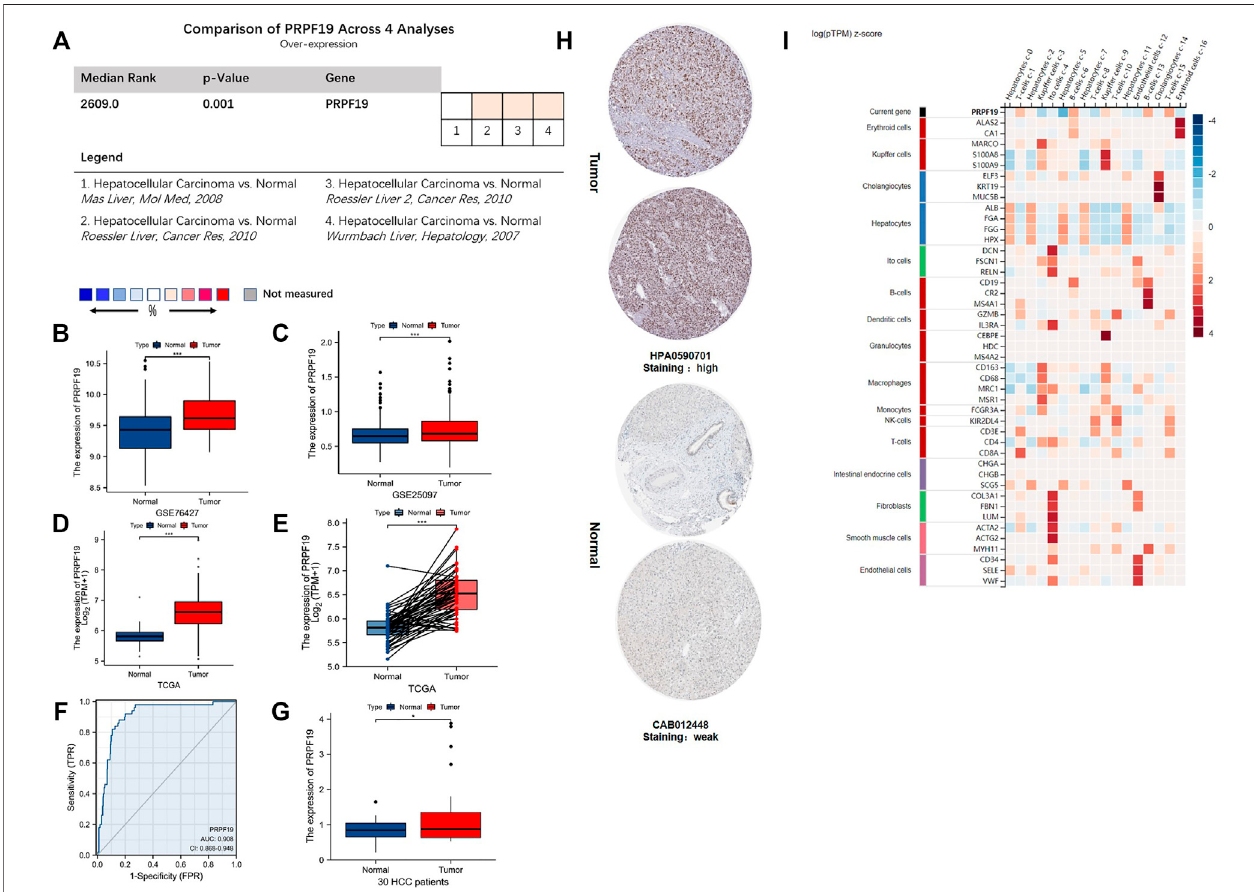
FIGURE 2 | The mRNA and protein expression of PRPF19 in liver cancer. (A – C) Overexpression of PRPF19 was found at the Oncomine database and the GEO database series including GSE76427 and GSE25097. (D) PRPF19 expression in tumor and normal tissues in liver cancer (LIHC) from the TCGA database. (E) PRPF19 expression in indicated paired tumor and normal tissues in LIHC data of TCGA. Black lines connect paired tissues. (F) ROC analysis of PRPF19 shows promising discrimination power between tumor and normal tissues. (G) PRPF19 expression levels were measured in humans through qRT-PCR. (H) Representative immunohistochemistryimagesofPRPF19proteinexpressionlevelsinLIHCandnon-cancerouslivertissuesderivedfromtheHPAdatabase. (I) PRPF19expressionheat map in each cell existed in normal liver tissues (HPA). Data shown as mean ± SD. * p < 0.05, ** p < 0.01, *** p < 0.001, **** p <